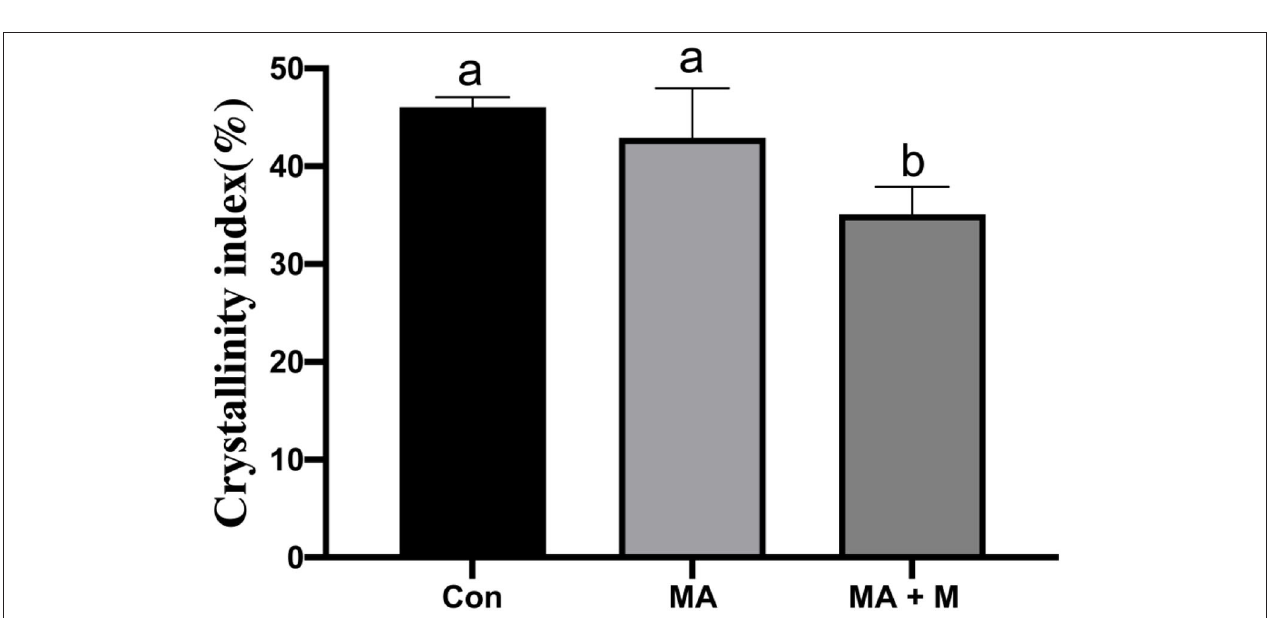
FIGURE 2 | The effect of MA pretreatment on the cellulose crystalline index (CrI, %) of rice straw was analyzed using X-ray diffraction (XRD). Con, no additive, control; MA, added microecological agents; MA + M, a combination of microecological agents and